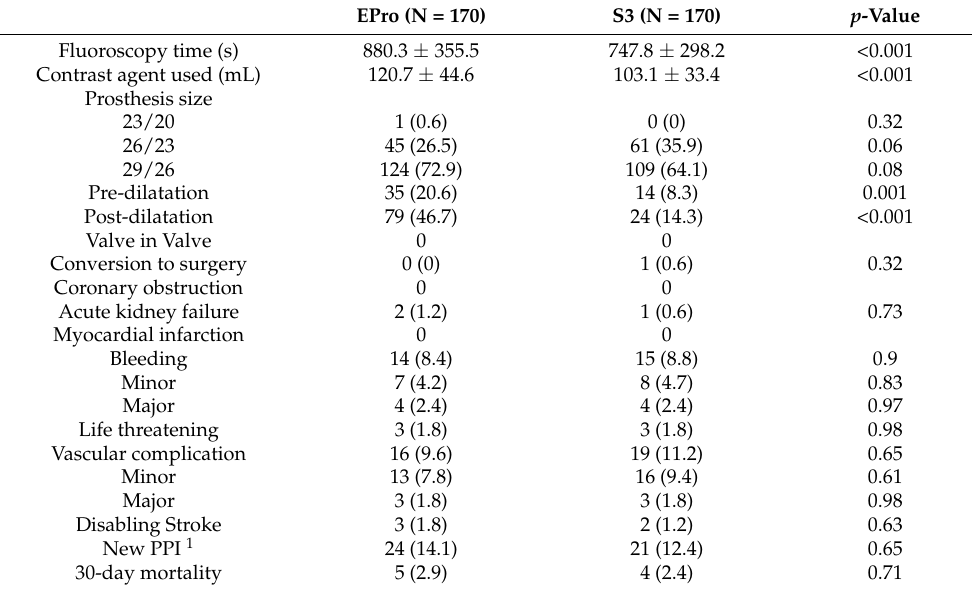
Table 2. Clinical and hemodynamic outcomes after transcatheter